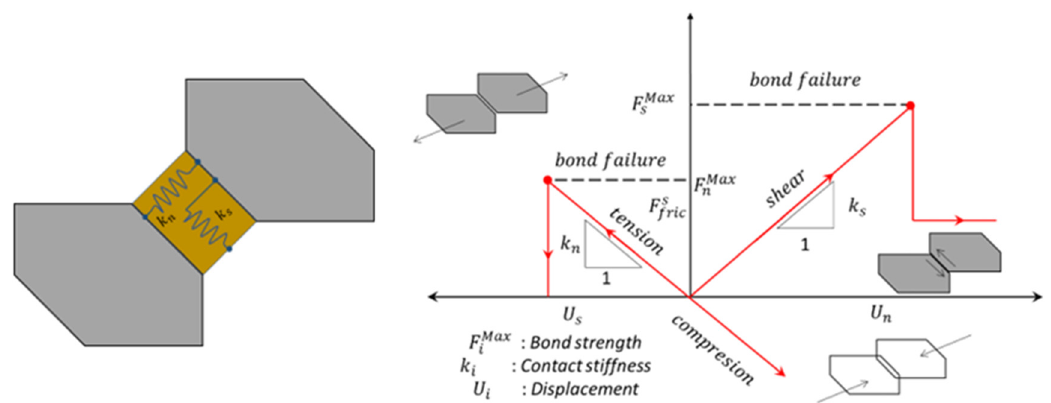
Figure 5. UDEC calculation principle of the rock fracture propagation process (redrawn after [26]).